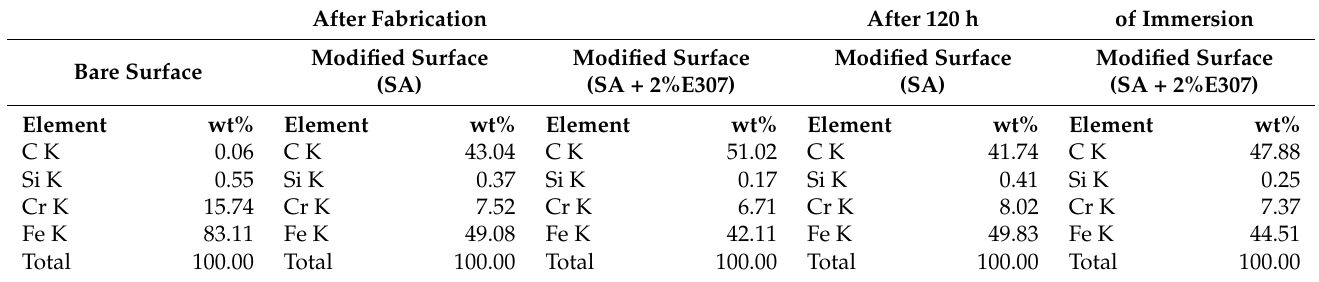
Table 4. EDAX analysis of the bare surface and modified surfaces of SS type AISI 410S after one- hour immersion in an ethanolic solution of SA [27] and (SA + 2.0% of E307) [27] and after 120 h of immersion in a simulated solution of acid rain with pH =